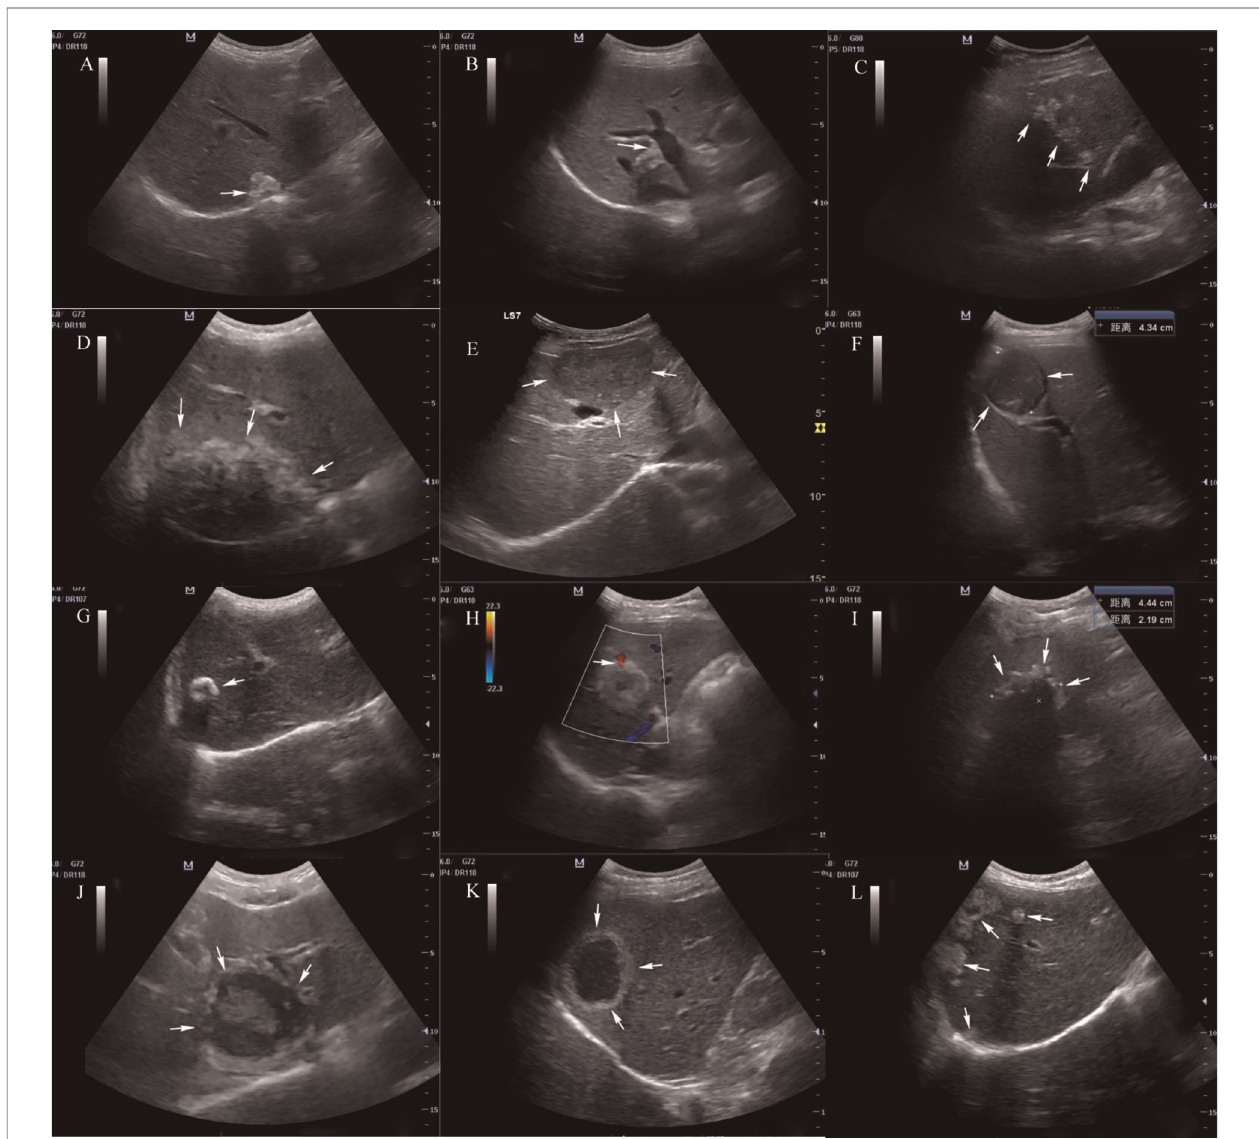
FIGURE 1 | Ultrasonographic manifestations of hepatic alveolar echinococcosis Arrows in the fi gure: ( A ) hyperechoic nodular lesion; ( B ) angulation deformity of lesion edge; ( C ) treelike or beaded growth; ( D ) in fi ltration type; ( E ) mass type; ( F ) tumor-like sign; ( G ) calci fi cation type; ( H ) vascular truncation sign; ( I ) “ hailstorm ” sign; ( J ) “ island ” sign; ( K ) “ pseudocyst ” type; ( L ) multiple AE lesions in